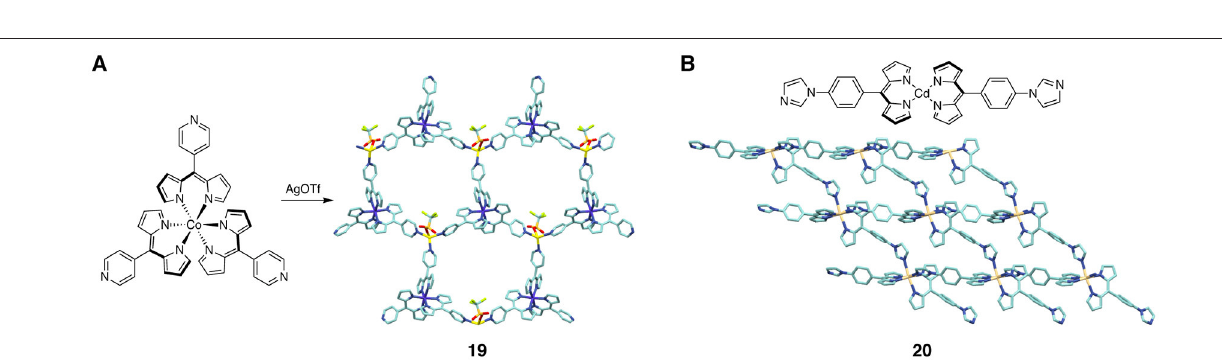
FIGURE 11 | (A) Crystal structure of self-assembled MOF 19 based on tris(dipyrrinato)cobalt(III) metalloligand and Ag(OTf). (B) Crystal structure of luminescent MOF 20 consisting of the imidazolyl-appended bis(dipyrrinato)cadmium(II) complex.